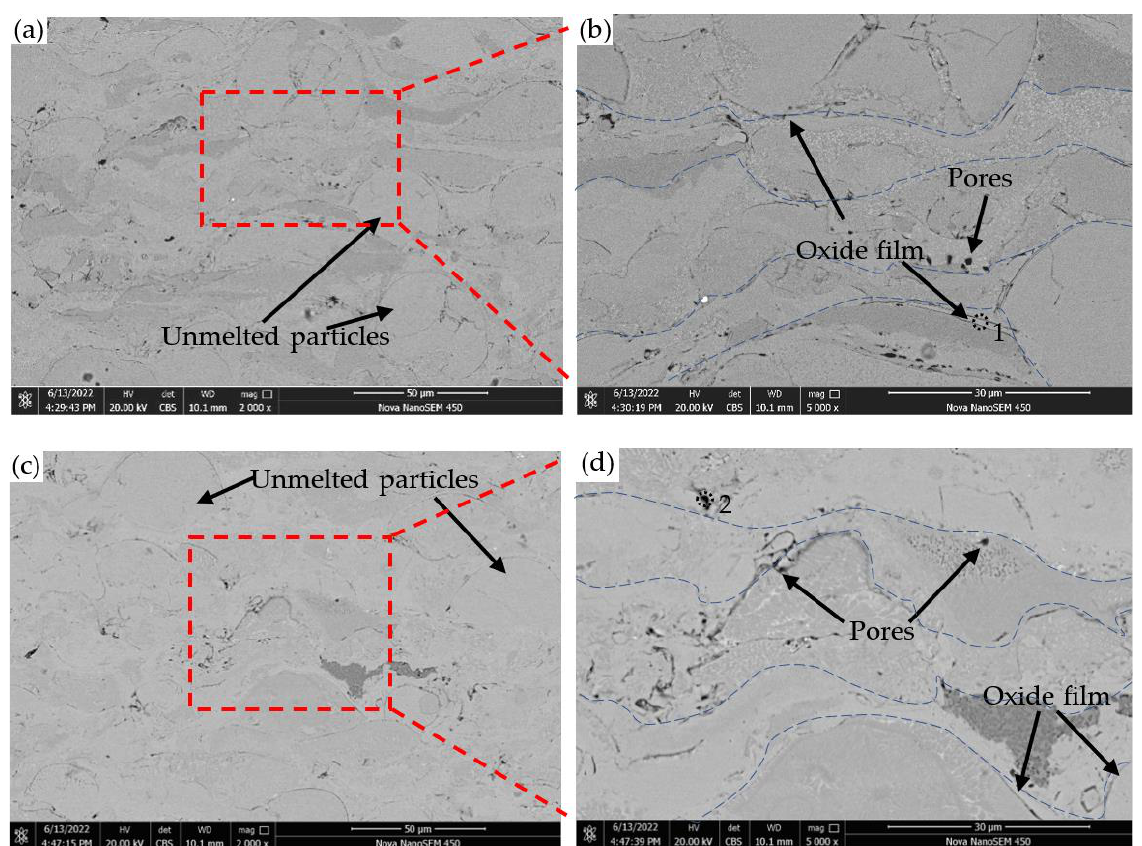
Figure 4. ( a , b ) Section morphology of Stellite 20 coating deposited by HVAF; ( c , d )Section morphol- ogy of Stellite 20 coating deposited by HVOF. Table 4. EDS results of the corresponding areas of section morphology (at%). Table 4. EDS results of the corresponding areas of section morphology